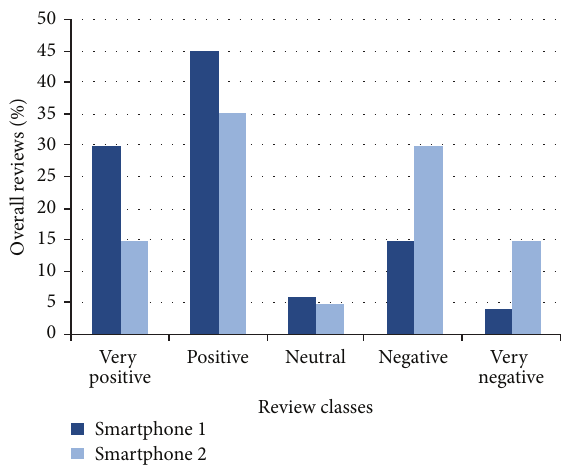
Figure 3: Fine-grained classification of user